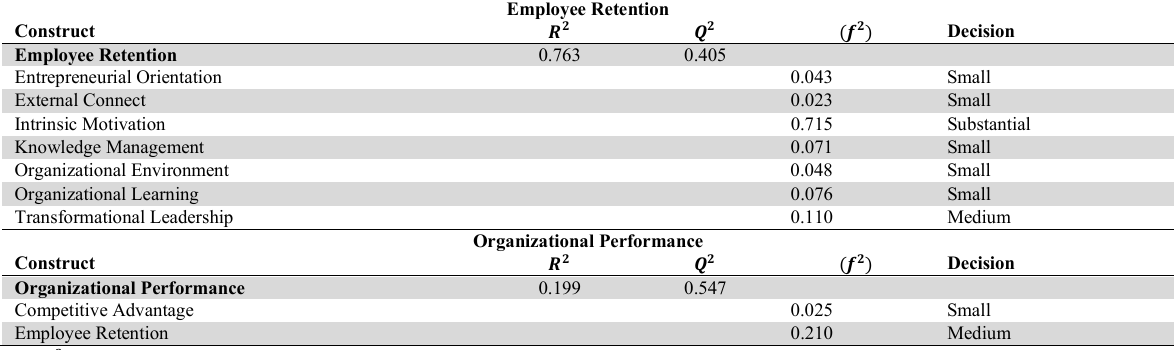
Effect size analysis (𝑓 (cid:2870) ) and predictive relevance 𝑄 (cid:2870)